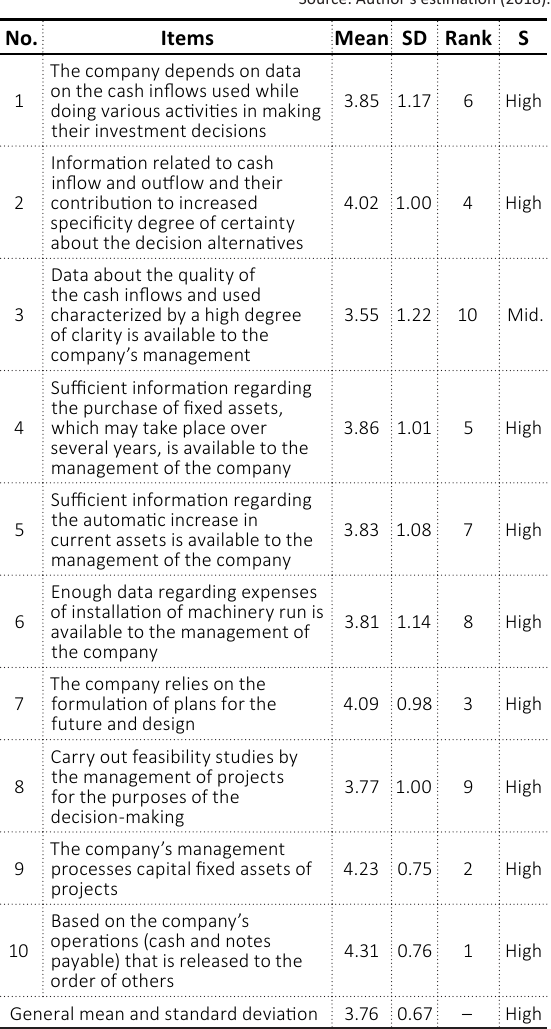
Table 8. Items related to the first sub-hypothesis